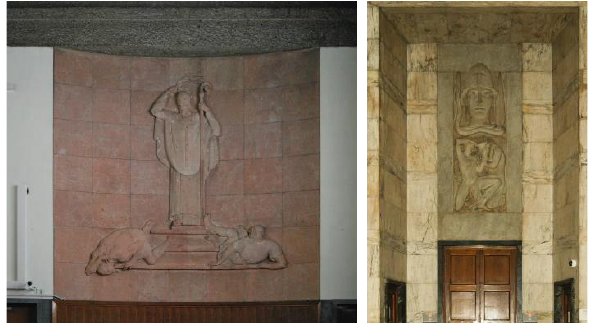
Fig. 4 and 5. Bas-relief for the plan dedicated to criminal trials. On the left inside a courtroom, on the right in the ambulatory.